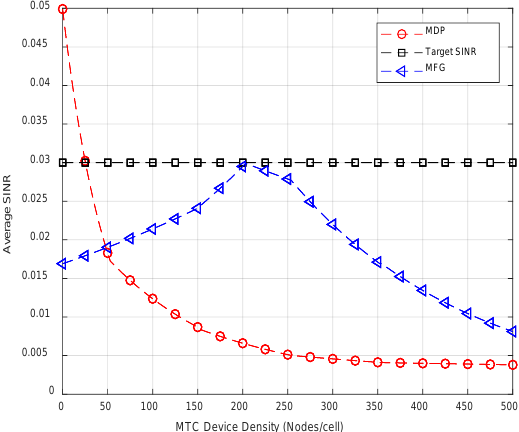
Figure 9. Impact of device density on the average SINR.